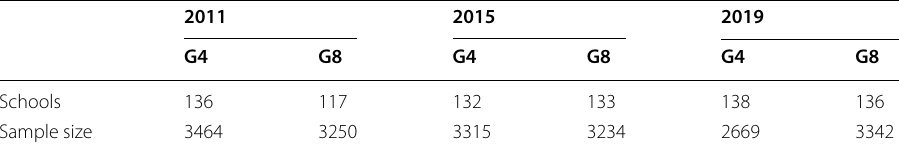
Table 1 School distribution of Hong Kong in TIMSS 2011, 2015, and